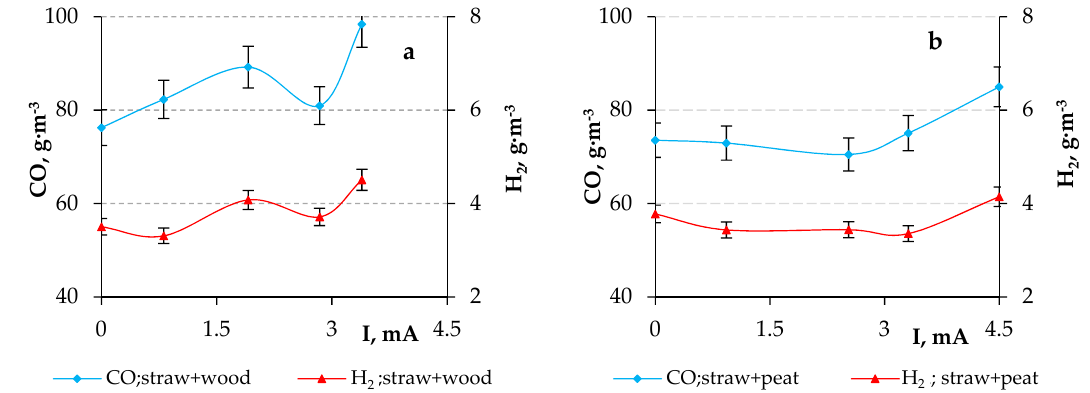
Figure 8. Electric field effect on the formation of volatiles at the gasifier outlet when co-firing straw with wood ( a ) or with peat ( b ).